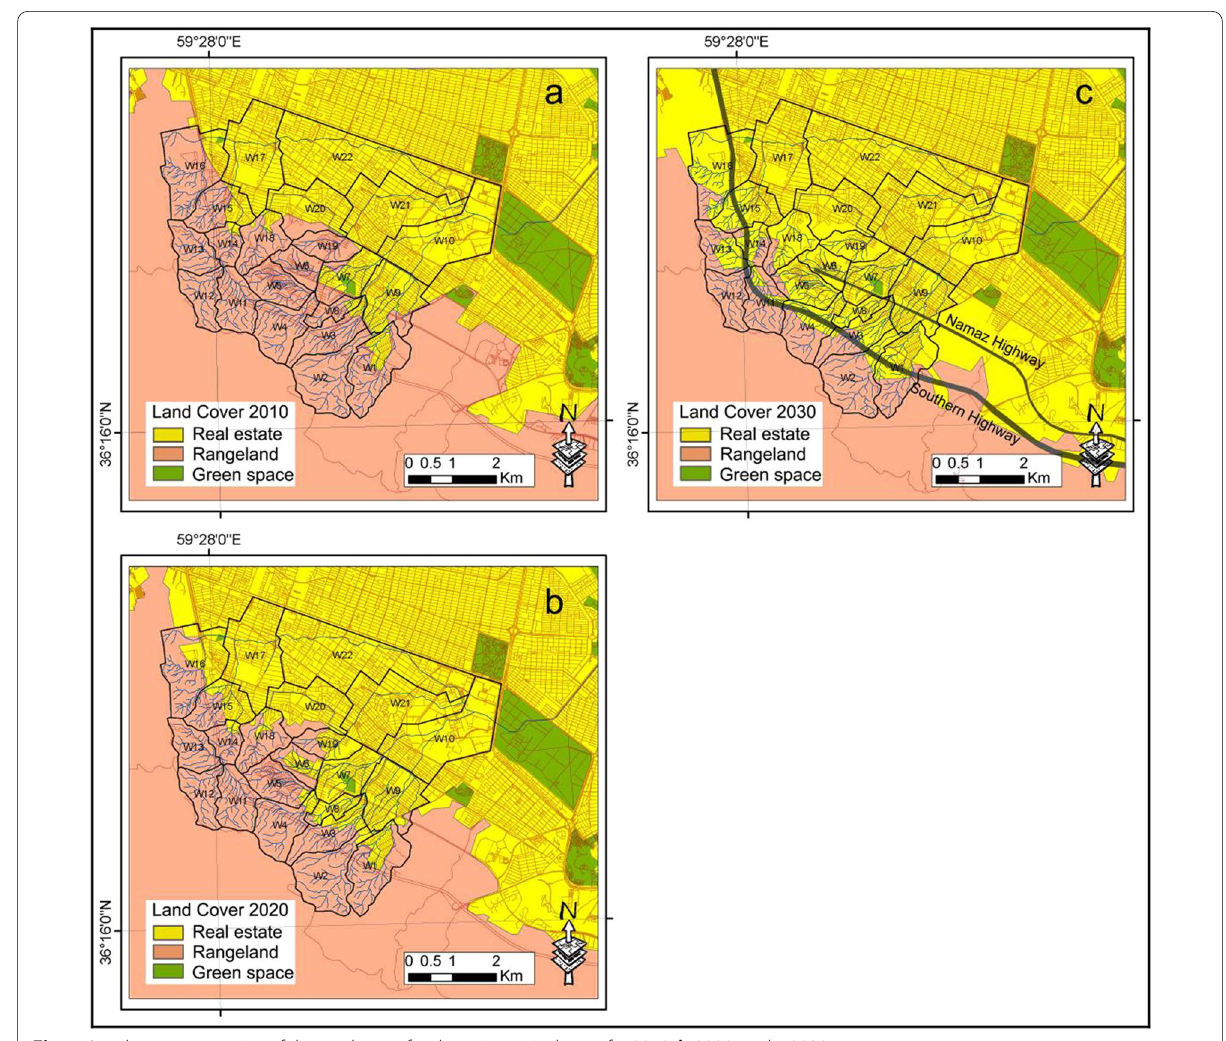
Fig. 4 Land cover properties of the study area for three time windows of a 2010, b 2020, and c